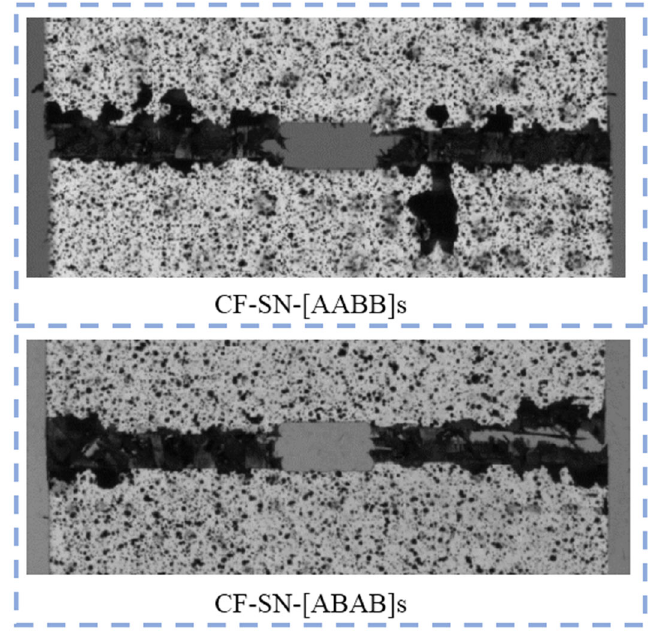
Figure 17. Local failure characteristic diagram of tensile specimens with different lay-up sequences; the outer plain fabric of the CF-SN-[AABB]s specimen was found to be cracked first, and the internal ±45° layer failed before the whole specimen was completely broken. In contrast, the CF-SN-[ABAB]s specimen fractured almost completely with more evenly distributed stress.